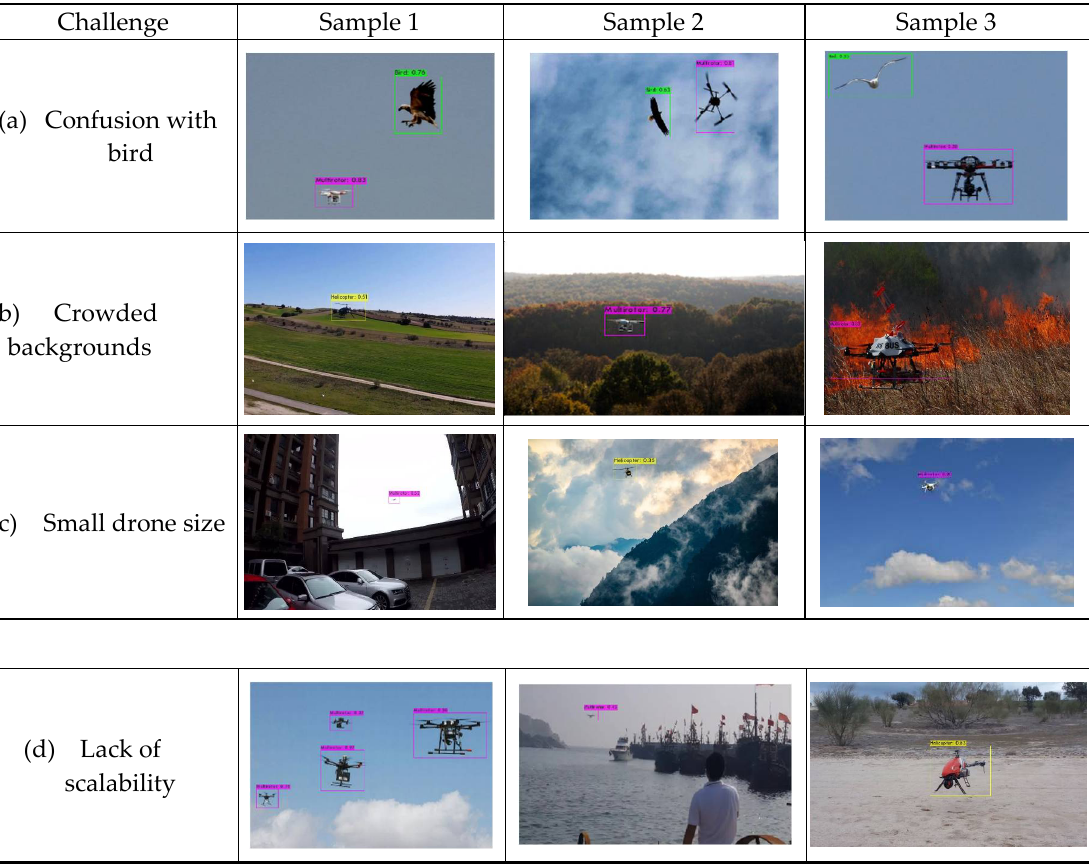
Figure 16. Some samples of detection and recognition results of the proposed network. 4.3. Model Evaluation in Addressing the Challenges Drone detection and recognition always face challenges such as the inability to iso- late the background, crowded backgrounds, lighting issues within the image, and the presence of occluded areas. On the other hand, the small size of the drone and its far dis- tance caused it to be confused with the bird and reduced the accuracy of the diagnosis.